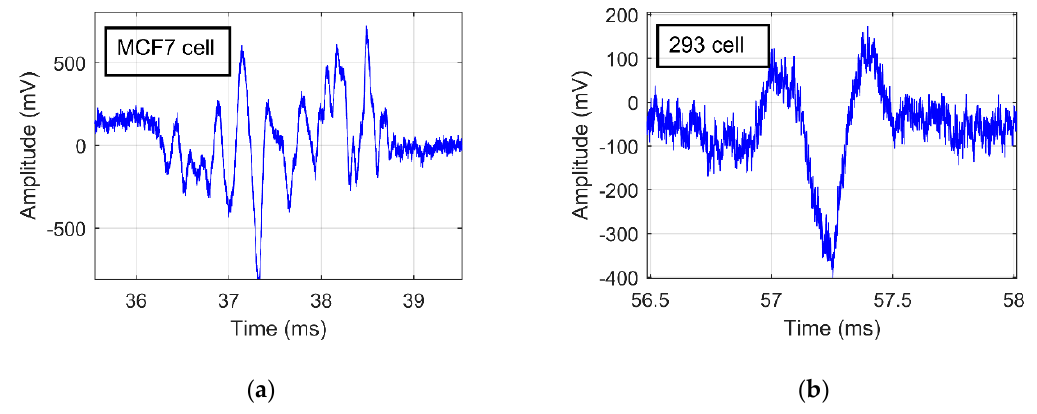
Figure 10. The SMI bursts of individual human living cells: ( a ) MCF7 cells; ( b ) 293 cells.